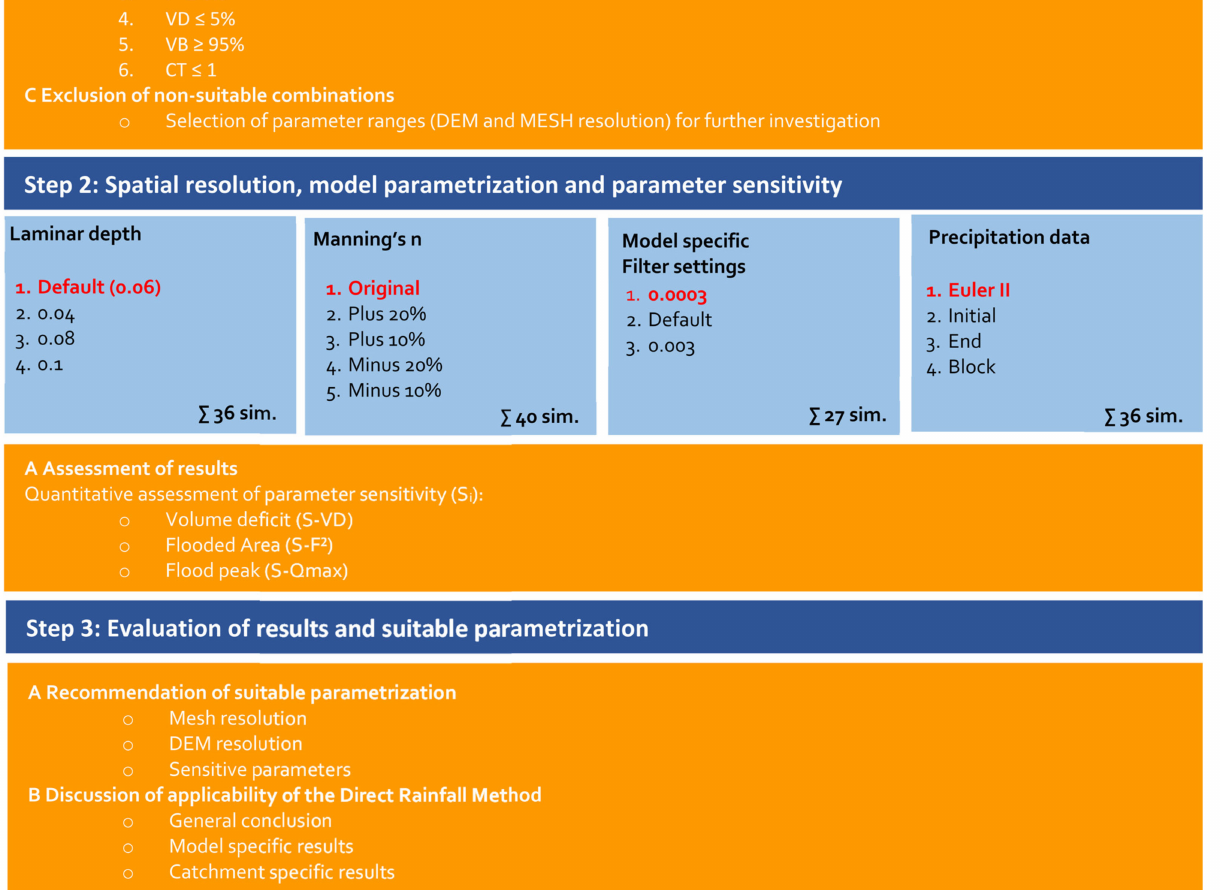
Figure 1. Schematic overview method for systematic analysis of model